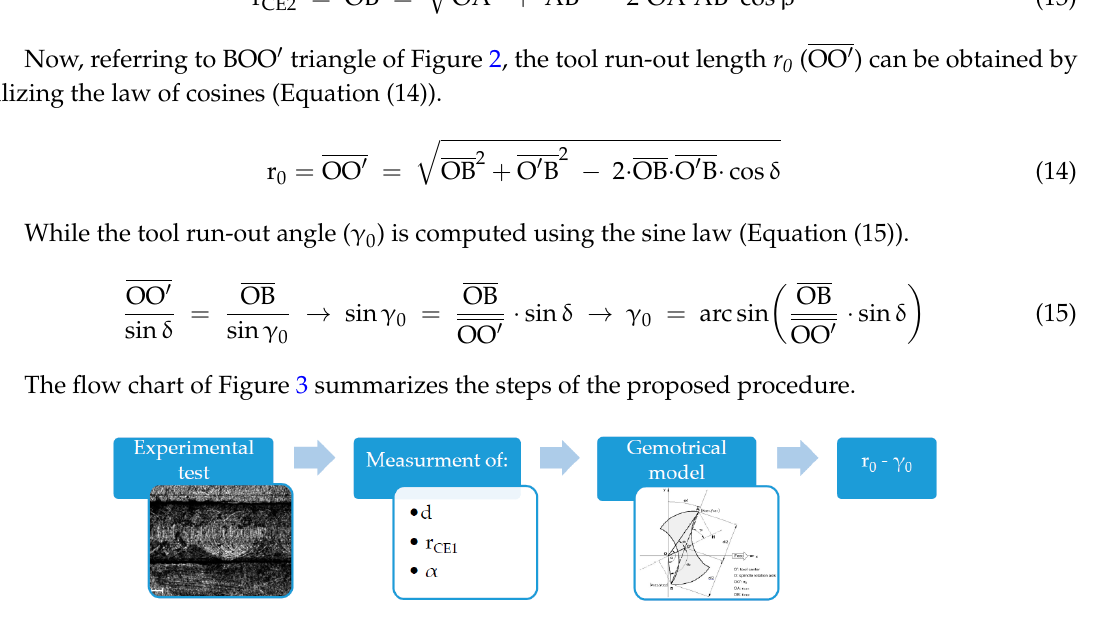
Figure 3. Procedure for computing tool run-out parameters (r 0 and γ 0 ).